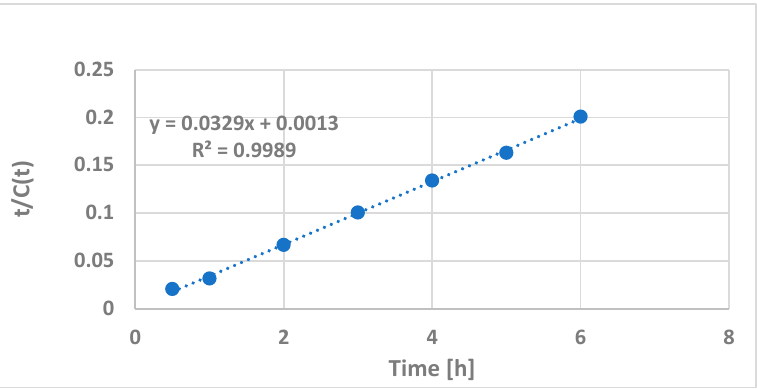
Figure 8. Extraction kinetics of PPT according to linearized Peleg’s Equation (3). Variable parameter—extraction time; constant parameters (previously selected conditions)—solvent ethyl acetate, room temperature and liquid-to-solid ratio of 10 ( v / w ). R—regression coefficient. The resulting linear expression